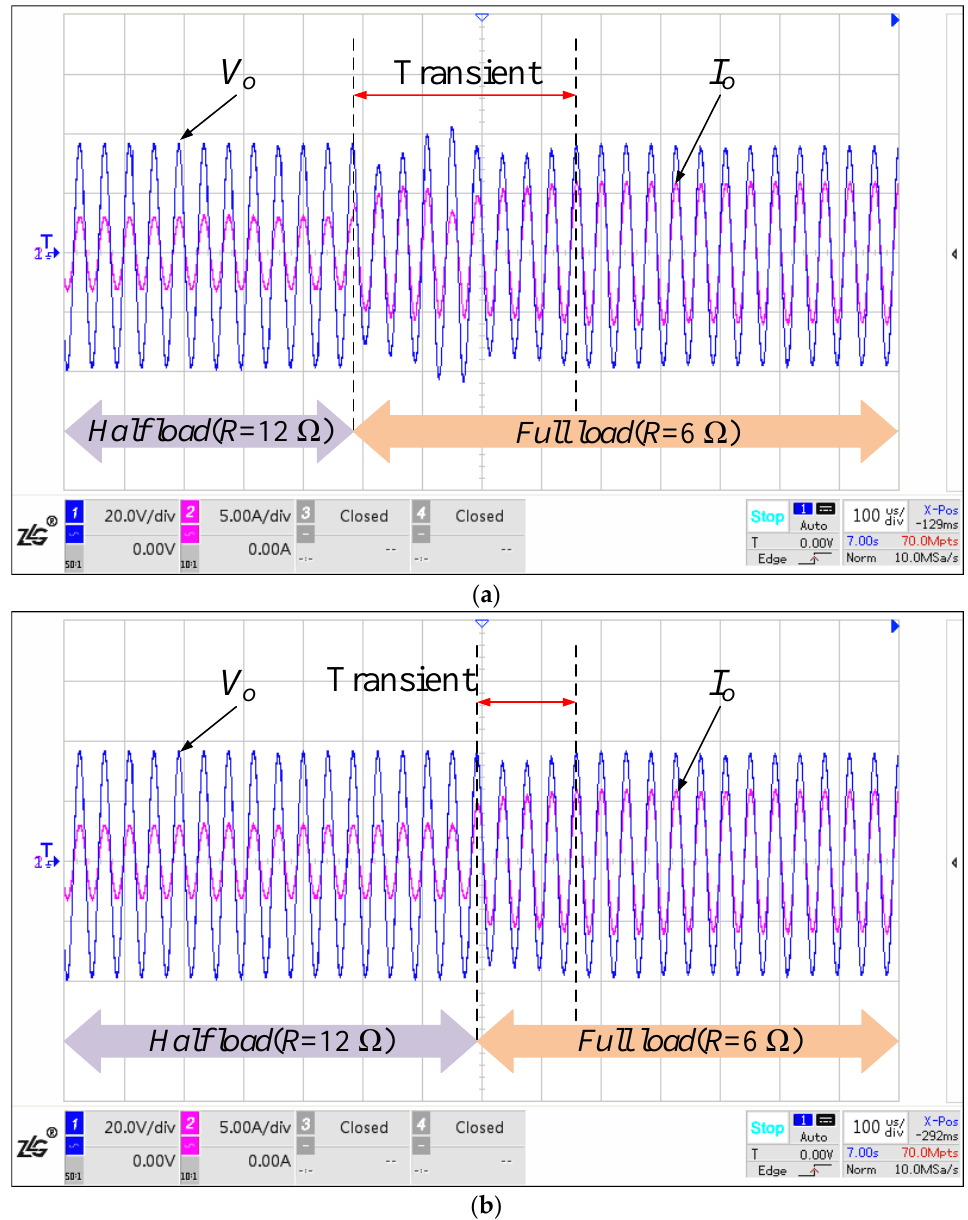
Figure 18. Transient performance comparison of load variation: ( a ) with PSM; ( b ) with I-PSM.